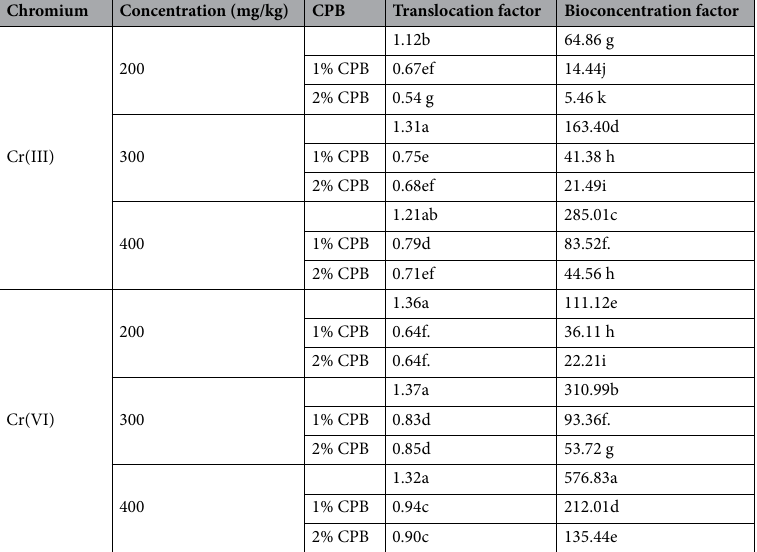
Table 1. Translocation factor and bioconcentration factor of tomato leaf due to the effect of soil amendment with plant biomass of Cloncurry buffel grass (CPB) under Cr(III) and Cr(VI) stress. Values with different letters (n = 3) at their top show a significant difference (p ≤ 0.05) as determined by the LSD